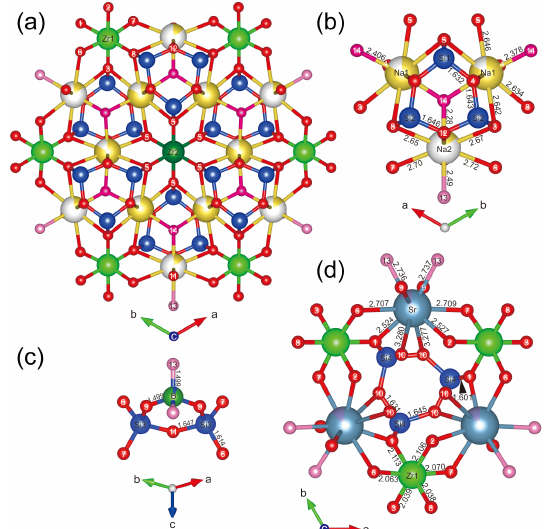
Figure 4. The crystal structure for bobtraillite (Na ions shown in yellow, Sr in gray, O in red, OH in pink, H 2 O in cherry red, and vacancy in